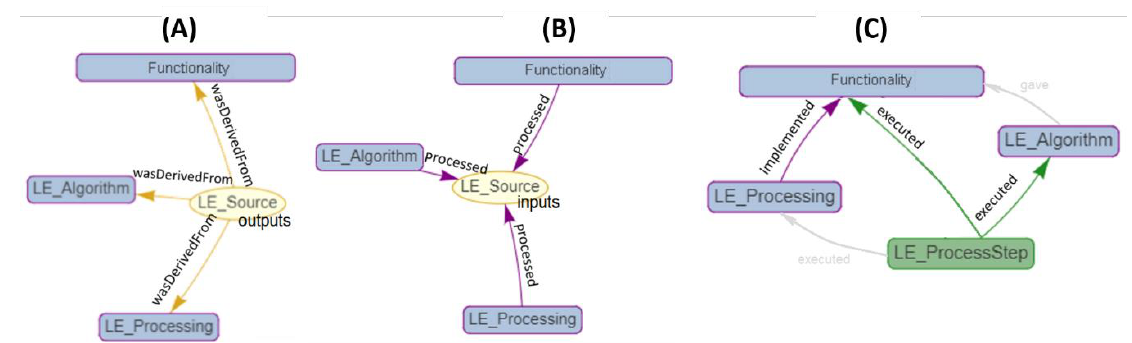
Figure 5. ( A ) connects entities (LE_Source—outputs) with entities (LE_Processing, LE_Algorithm, Functionality). ( B ) connects entities (LE_Processing, LE_Algorithm, Functionality) with entities (LE_Source—intputs). ( C ) connects the LE_ProcessStep, LE_Processing, LE_Algorithm, and Functionality.